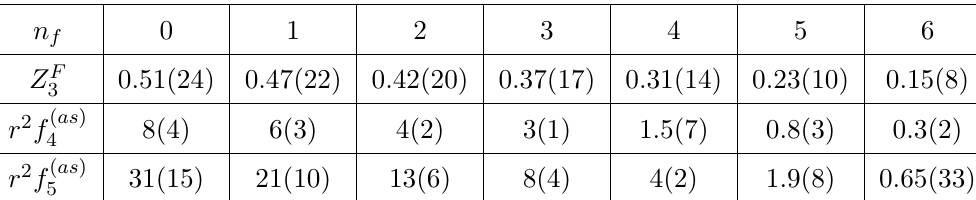
, of the leading renormalon of the force for di(cid:11)erent number 3